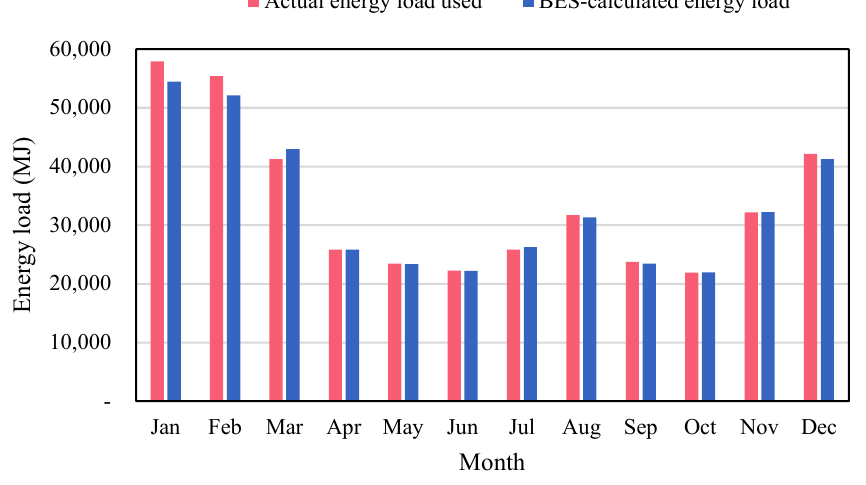
Figure 11. Comparison of actual and BES-computed monthly energy loads of the office building.